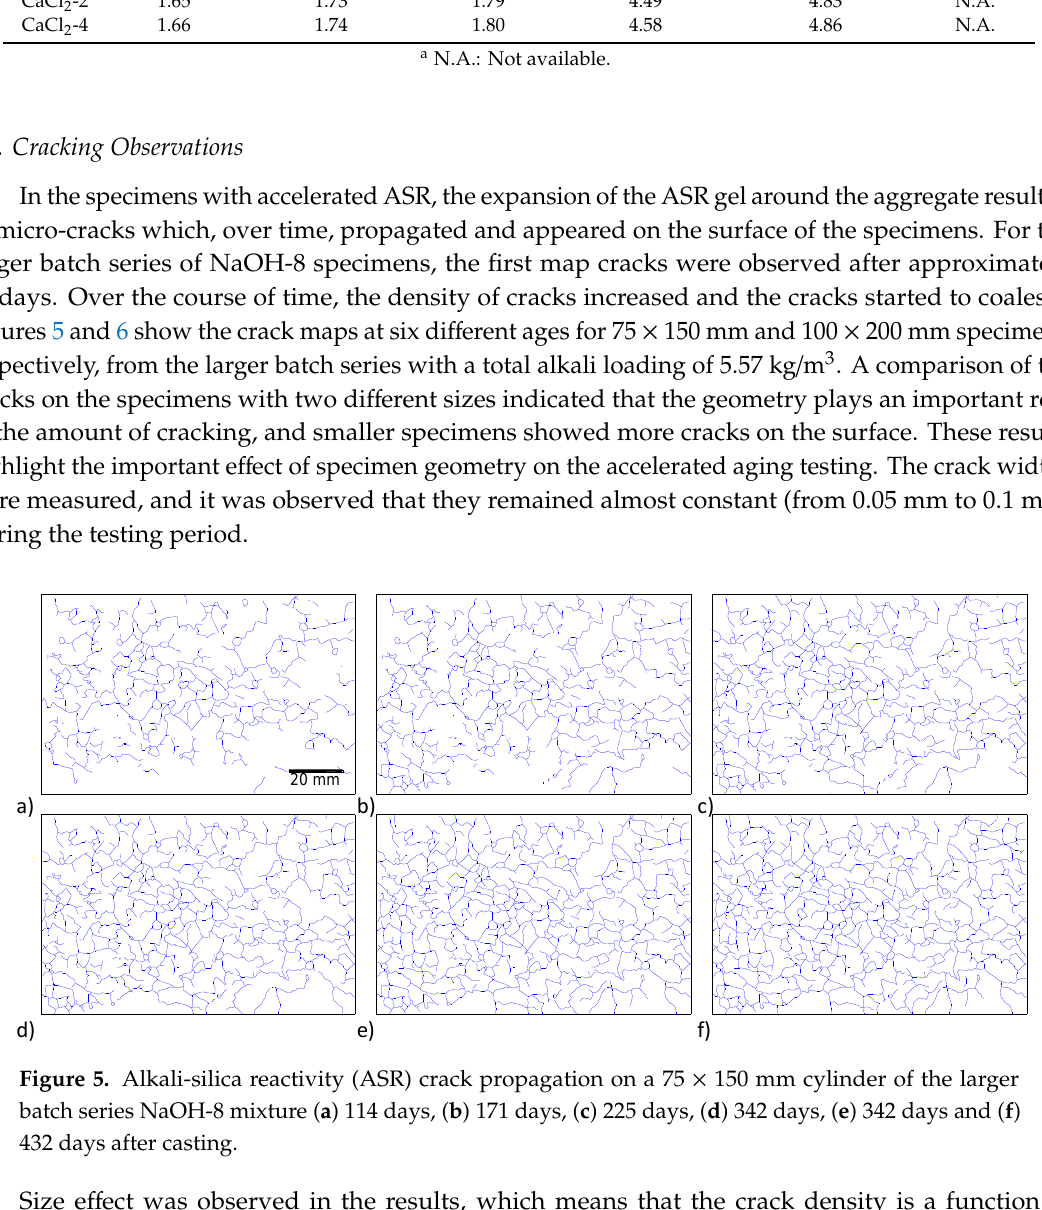
Figure 6. Alkali-silica reactivity (ASR) crack propagation on a 100 × 200 mm cylinder of the larger batch series NaOH-8 mixture ( a ) 114 days, ( b ) 171 days, ( c ) 225 days, ( d ) 342 days, ( e ) 342 days and ( f ) 432 days after casting. Size effect was observed in the results, which means that the crack density is a function of the specimen size. Both samples were of the same concrete mixture and were maintained in the same environmental conditions. In the smaller cylinders, the cracks were fully joined together, and further expansion did not create additional cracks, unlike the larger cylinders. As shown in Figure 7, after 117 days, from the smaller specimens (75 × 150 mm), an average crack density of 19.5 × 10 −3 was observed and this value kept increasing over time and reached to 33.5 ×10 −3 at 432 days. The larger specimen showed a reduced crack density. At the same testing times (117 days and 432 days), the